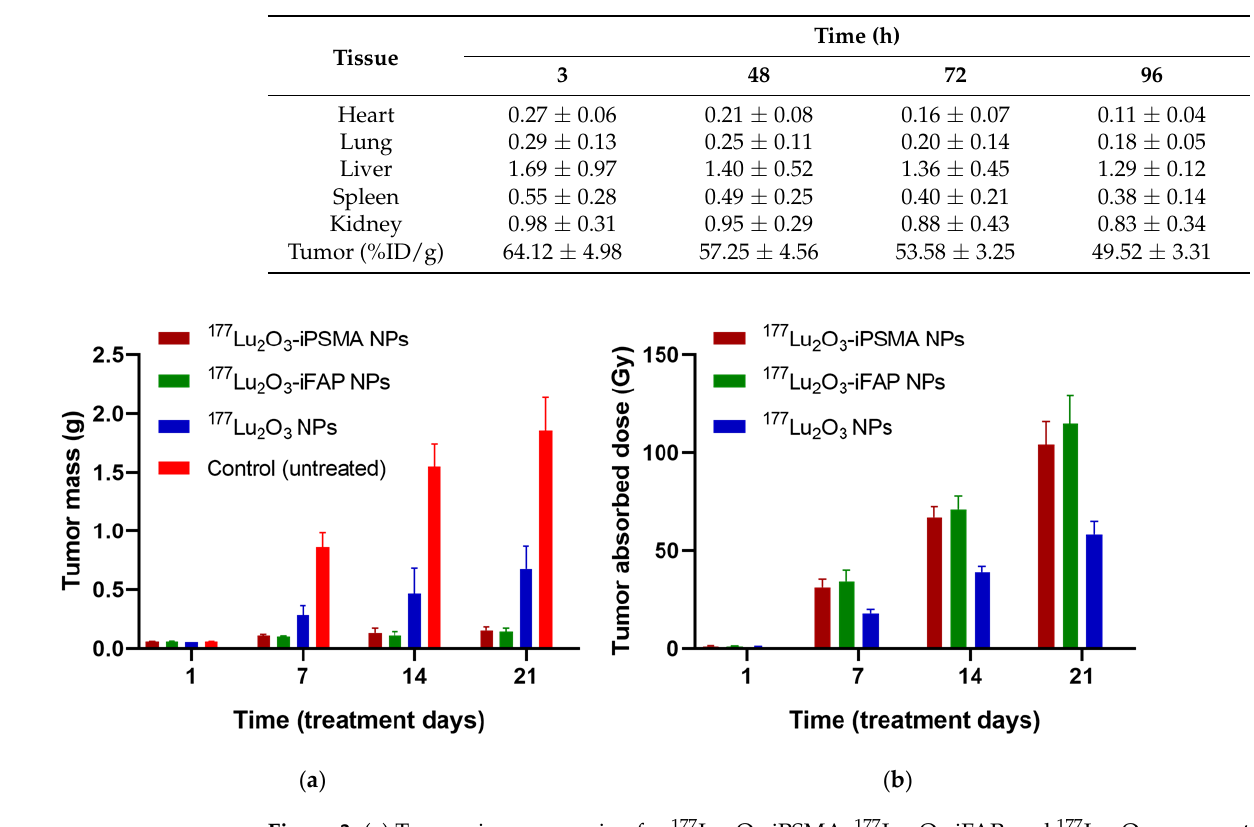
Figure 3. ( a ) Tumor size progression for 177 Lu 2 O 3 -iPSMA, 177 Lu 2 O 3 -iFAP, and 177 Lu 2 O 3 groups at different days of the treatment, without statistically significant difference ( p > 0.05) between 177 Lu 2 O 3 -iPSMA and 177 Lu 2 O 3 -iFAP and with statistically significant difference ( p < 0.05) of 177 Lu 2 O 3 -iPSMA and 177 Lu 2 O 3 -iFAP vs. 177 Lu 2 O 3 nanoparticles and the control group; ( b ) The mean radiation absorbed doses of 177 Lu 2 O 3 -iPSMA, 177 Lu 2 O 3 -iFAP, and 177 Lu 2 O 3 delivered to HCT116 tumors. Significant uptake of [ 18 F]FDG in tumors produces high SUV values, indicating high